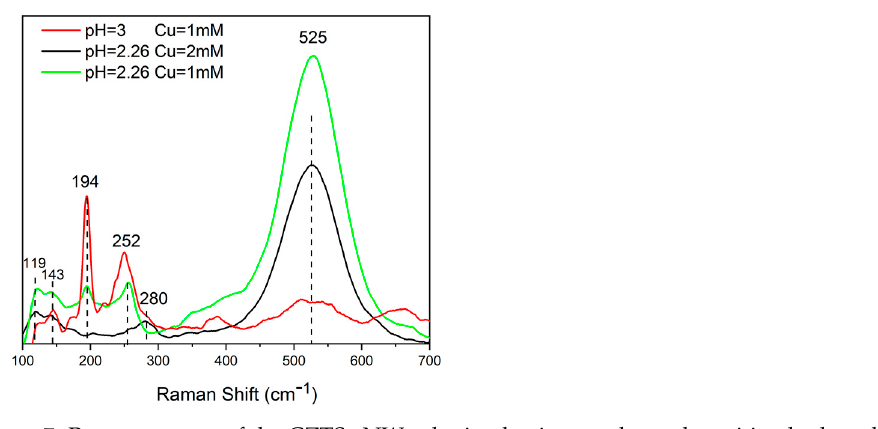
Figure 7. Raman spectra of the CZTSe NWs obtained using an electrodeposition bath at different pHs and Cu content (see Table 1). Table 2. Summary of Raman analysis of CZTSe nanowires.